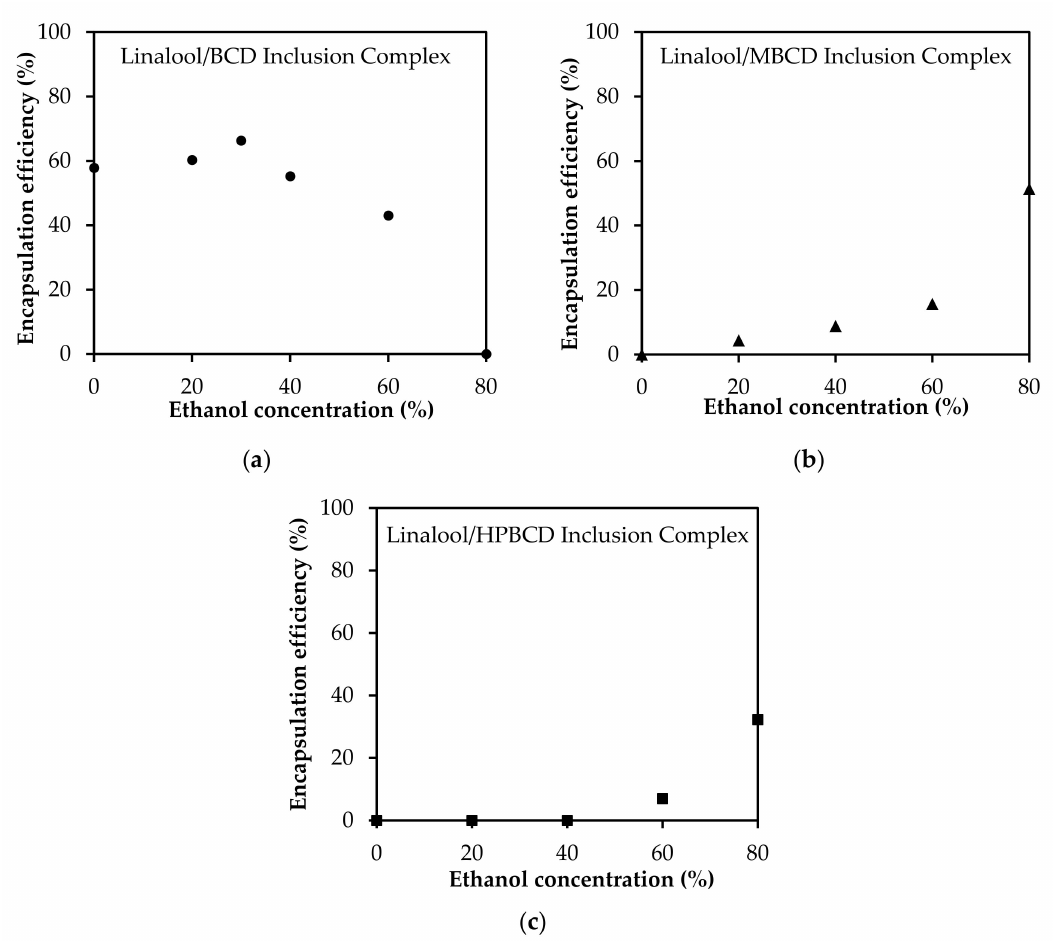
Figure 13. The effect of ethanol content on the encapsulation efficiency of ( a ) linalool/BCD inclusion complex, ( b ) linalool/MBCD inclusion complex, and ( c ) linalool/HPBCD inclusion